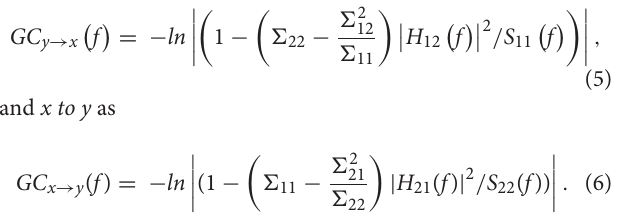
− 1 A 11 A 12 . A 21 A 22 (cid:19) (cid:18)